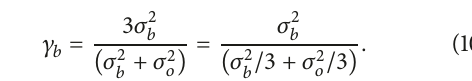
TEe with RE( A 𝑒 ) =